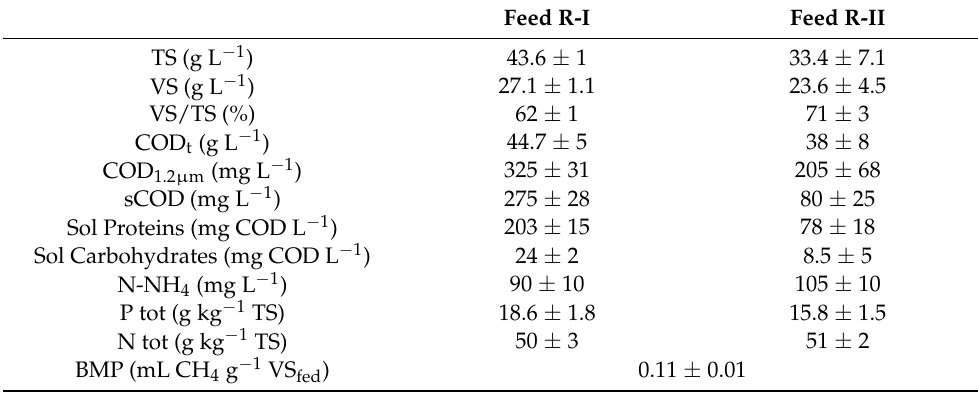
Table 1. Average characteristics of the feedstocks used for R-I and R-II.